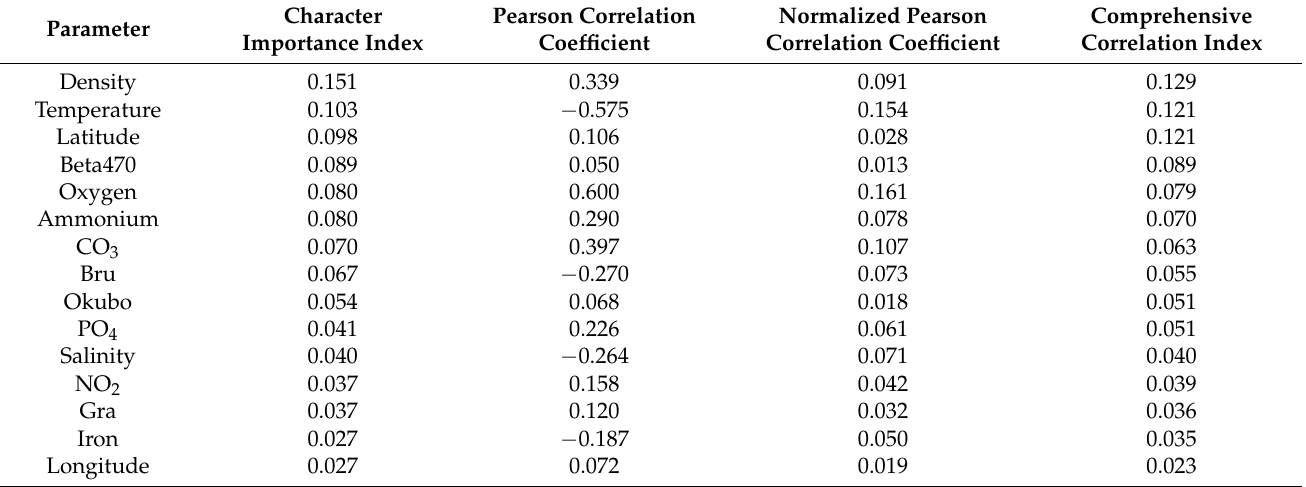
Figure 5. Comprehensive importance of the 15 environmental factors of the analyzed samples. Table 3. Comprehensive correlation indexes.